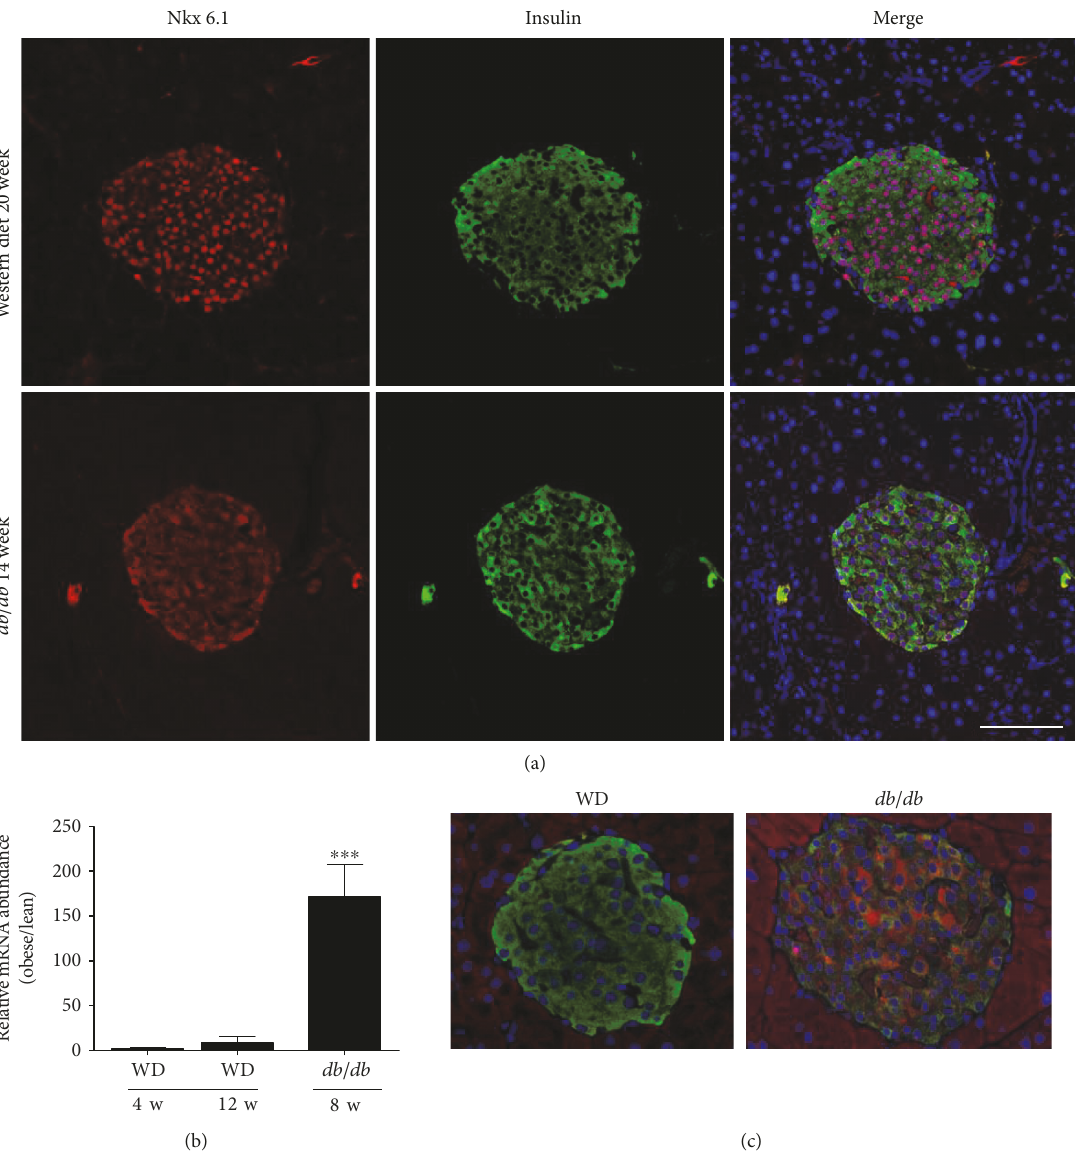
Figure 10: Markers of dedi ff erentiation are present in islets of db/db , but not weight-matched WD-fed mice. (a) Immuno fl uorescent analysis of islets from weight-matched WD-fed mice (top row) and db/db mice (bottom row) showing Nkx6.1 (red), insulin (green), and DAPI (blue). In the merged image, note the loss of double-positive nuclei (DAPI plus Nkx6.1; purple color) in the db/db mice but not in the WD-fed mice. (b) Expression of the Aldh1a3 gene in islets isolated from mice fed a WD for 4 or 12 weeks normalized to mice fed a control diet compared with db/db mice at 8 weeks of age (normalized to lean db /+ controls). ∗∗∗ p < 0 001 versus both WD groups by one-way ANOVA. (c) Staining for Aldh1a3 protein (red) and insulin (green) in islets from weight-matched WD-fed mice (20 weeks on diet) versus db/db mice (14 weeks of